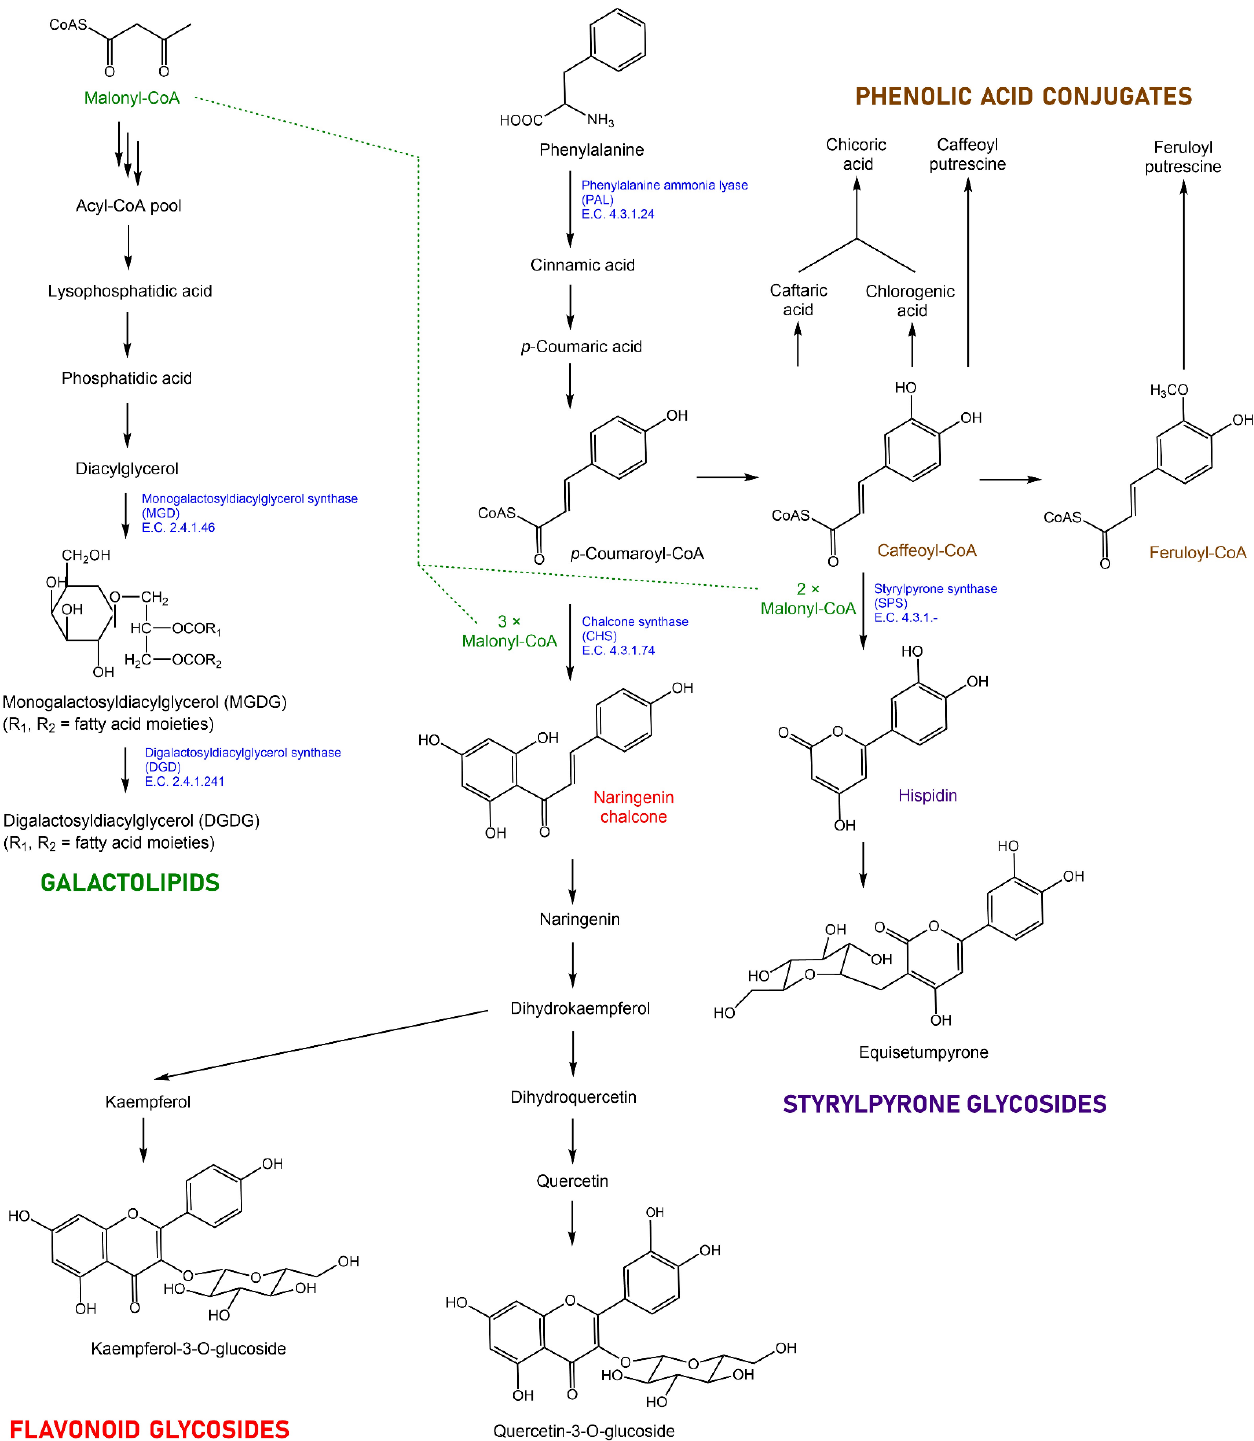
Figure 4. Representative structures of the main classes of specialized metabolites detected in Equisetum samples and outline of the relevant biochemical pathways. Enzymes selected for follow-up research (by assessing the expression levels of the corresponding genes) are shown in blue font. The transcript for CHS was dramatically more abundant in shoots when compared to rhizomes (530-, 210-, and 104-fold higher in E. arvense , E. hyemale , and E. telmateia sam- ples, respectively) (Figure 5A). These results are consistent with the preferential